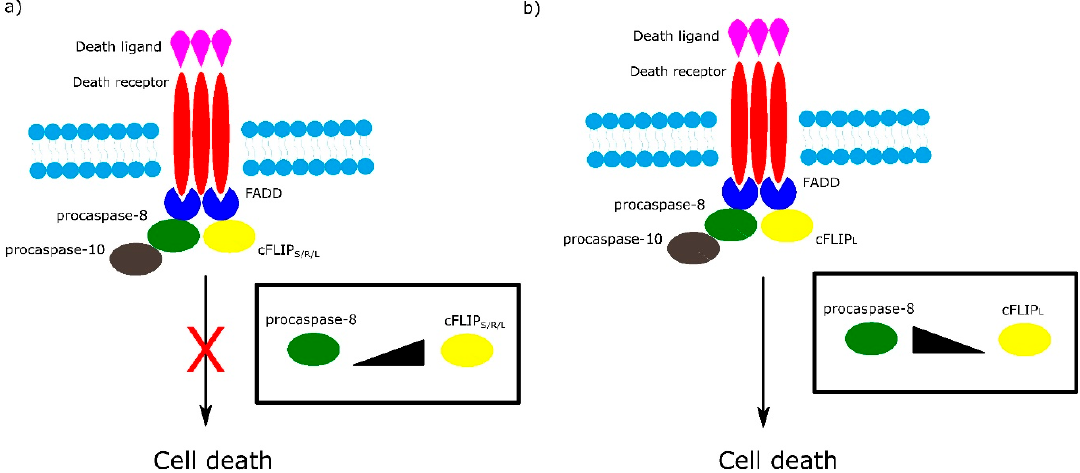
Figure 3. Role of different isoforms of cFLIP in extrinsic apoptotic pathway. The ratio of cFLIP to procaspase-8 in cFLIP-procaspases-8 heterodimer determines cell fate. ( a ) High levels of cFLIP S / R / L block formation of procaspase-8 oligomer and in consequence inhibit cell death. ( b ) At low level of cFLIP L , cFLIP L - procaspase-8 heterodimer activates cell death. Other regulators of apoptosis are inhibitors of apoptosis (IAPs). The mammalian IAPs, X-linked IAP (XIAP), cellular inhibitor of apoptosis protein 1 (cIAP1) and cellular inhibitor of apoptosis protein